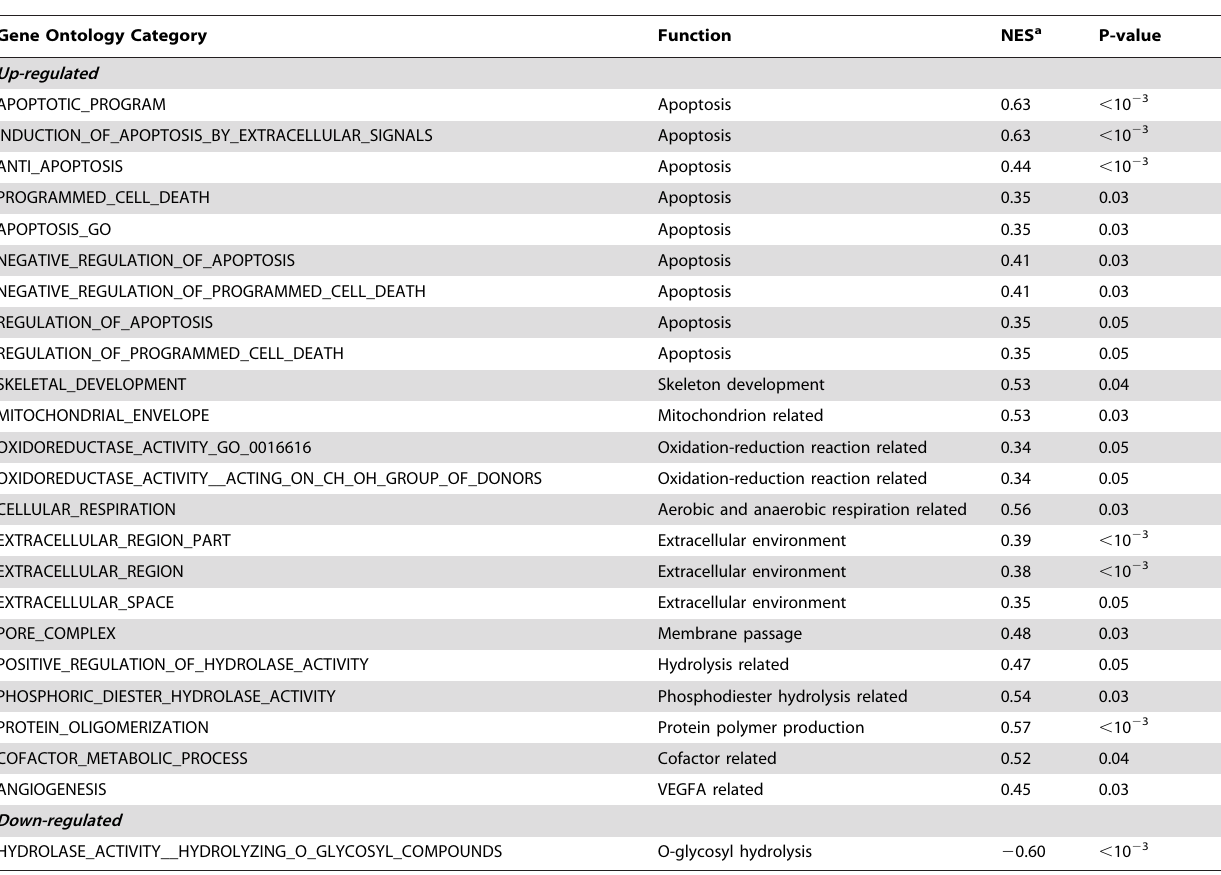
Table 2. Differently expressed gene ontology categories in KBD vs. control.